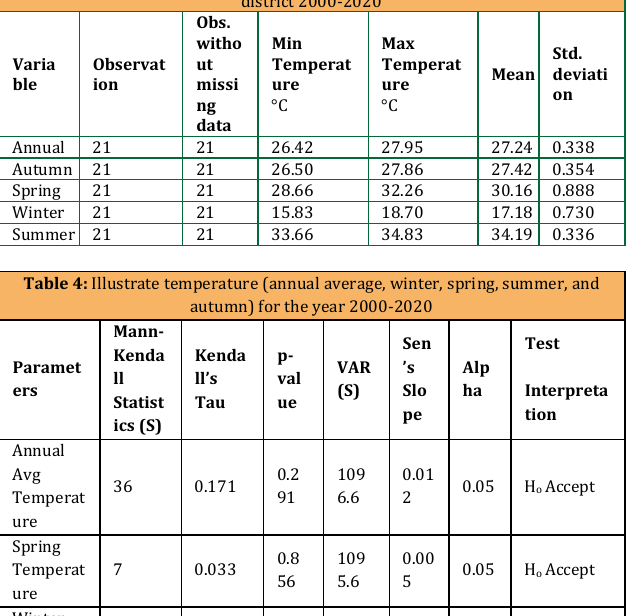
Table 3: Summary statistics of Annual and Seasonal Temperature of Ghotki Varia Observat ble ion